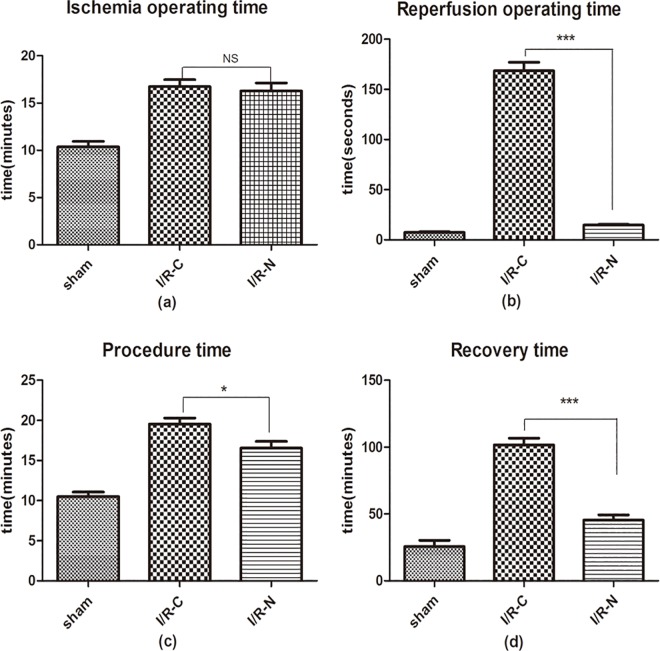
The surgical procedure time, reperfusion operating time and recovery time in new method were less than those of classic method.Ischemia operating time was no difference between two groups. The numbers of mice in sham, I/R-C and I/R-N group were 7, 15, 15 respectively. #p<0.05, ### p<0.001 vs. sham; *p<0.05, * * *p<0.0001 vs. I/R-C.